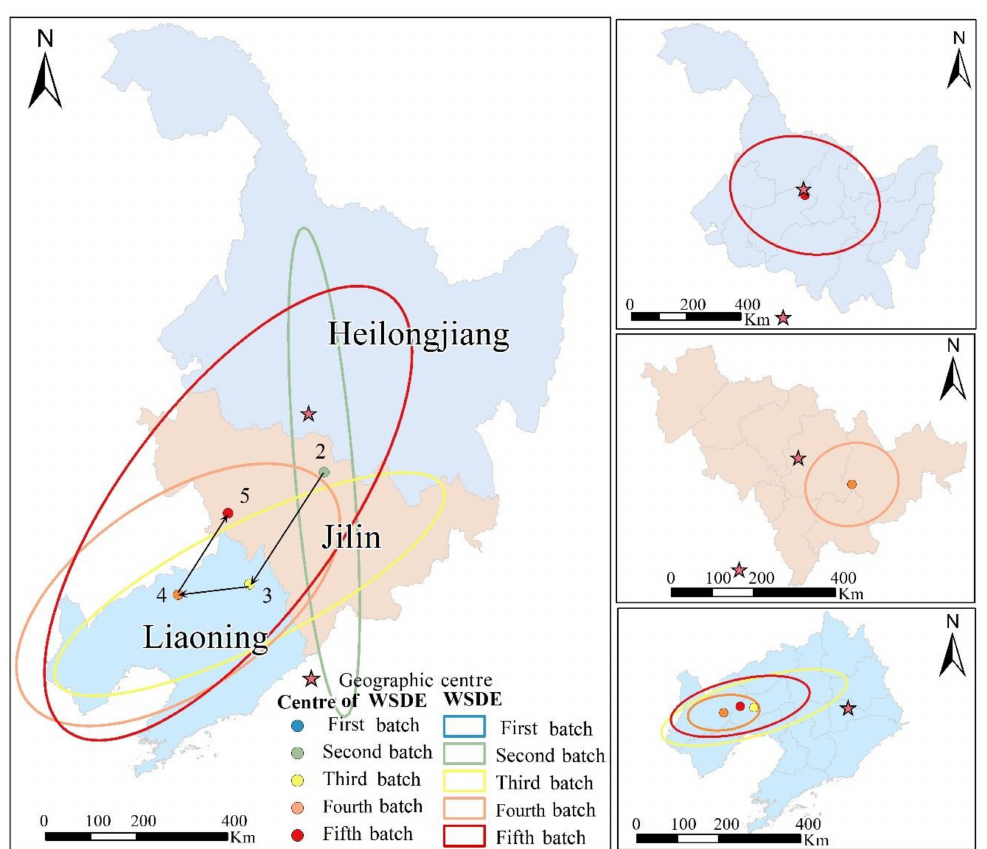
Figure 12. The WSDEs and the center trajectories for north-eastern China and subordinate provinces.